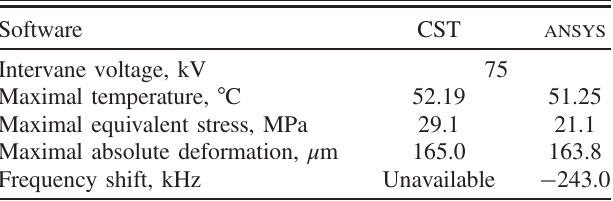
TABLE IV. Comparison of the simulated and analytically calculated RFQ analysis results.